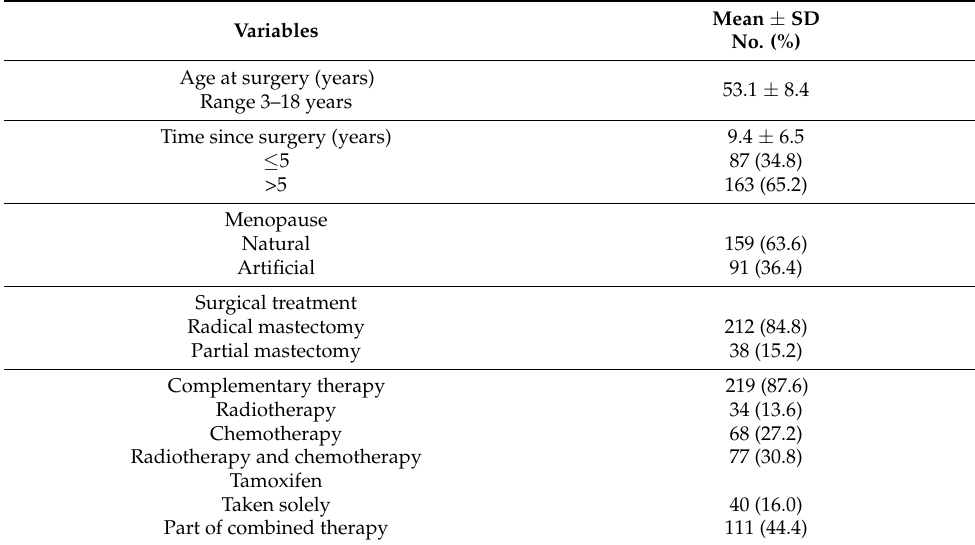
Table 2. Clinical data of breast cancer survivors ( n =